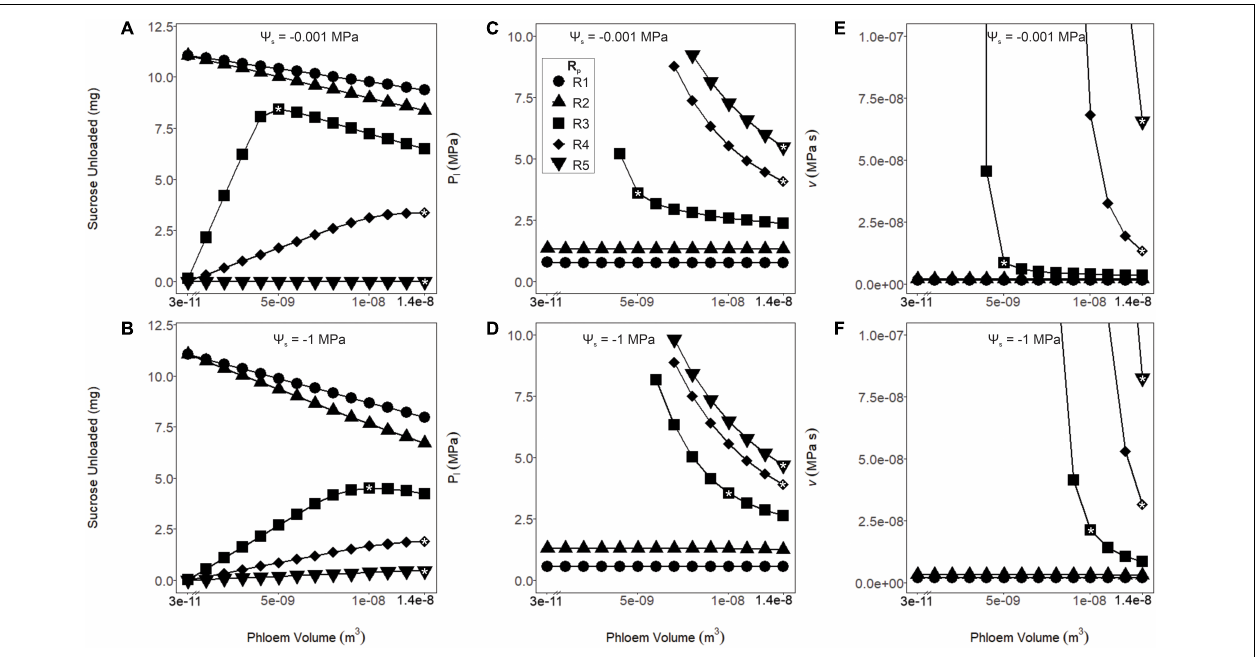
FIGURE 3 | Sucrose unloaded, phloem pressure (P l ) and viscosity ( v ) as a function of phloem volume and pathway resistance (R1–R5). These simulations were run under wet ( (cid:57) s = –0.001 MPa: A,C,E ) or dry ( (cid:57) s = –1 MPa: B,D,F ) soil conditions. (A,B) As phloem volume declined, sucrose export increased for the lower resistance pathways (R1 and R2). Export peaked at intermediate volumes and resistances (R3) and continued to increase at higher volumes and resistances (R4 and R5). This effect was intensified for the drier simulation. (C,D) Phloem pressure remained stable over all tested volumes for the lower resistance pathways (R1 and R2), while increased with lower volumes for the higher resistance pathways (R3–R5). For the higher resistance pathways and lower volumes, resulting pressures are not shown due to excessive values. (E,F) The phloem viscosity remained stable for lower resistance pathways (R1 and R2) over the range of volumes tested, while runaway viscosity began to occur at the lower phloem volumes for the higher resistance pathways (R3–R5). A drought scenario would induce the runaway viscosity effect at lower phloem volumes for these resistances. In subsequent analysis, volumes were chosen (white asterisks) for each resistance that maximized sucrose export while preventing the runaway viscosity effect over the range of (cid:57) s tested: R1 and R2; 3.57 e − 11 m 3 , R3; 1.04e − 8 m 3 , and R4 and R5; 1.37e − 8 m 3